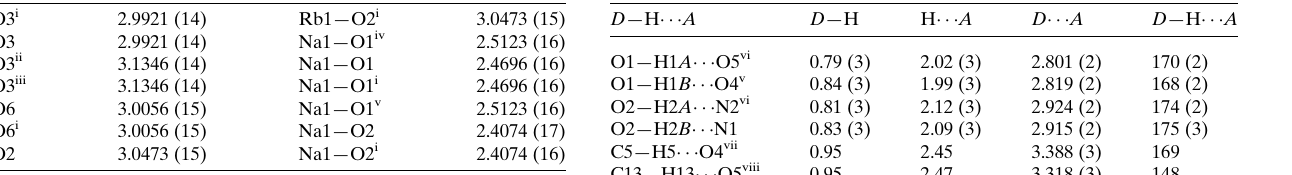
Table 2 Hydrogen-bond geometry (A˚ , (cid:5) ).